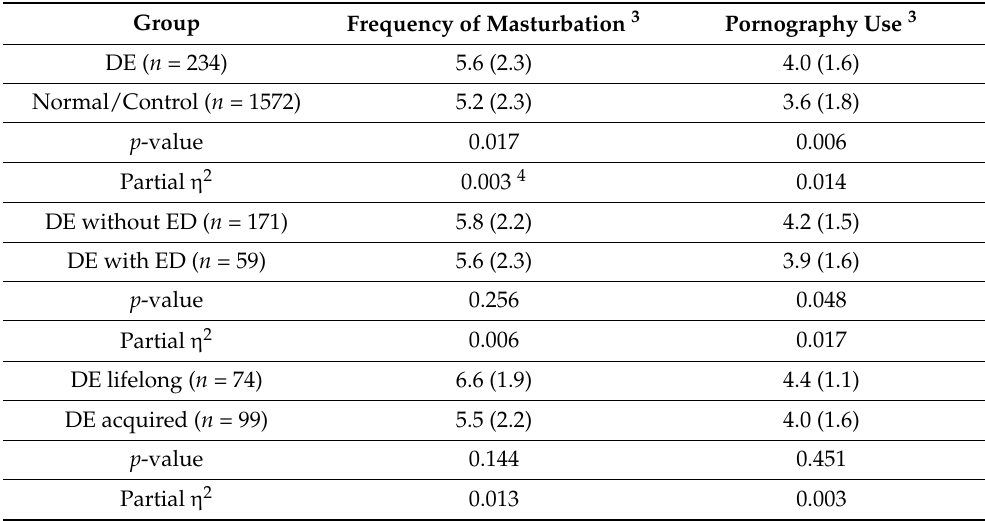
Table 2. Comparisons of Masturbation Frequency and Pornography Use (mean ± standard deviation in men with delayed ejaculation (DE) 1 vs. normal/control, DE with vs. without erectile dysfunction (ED), and lifelong vs. acquired groups 2